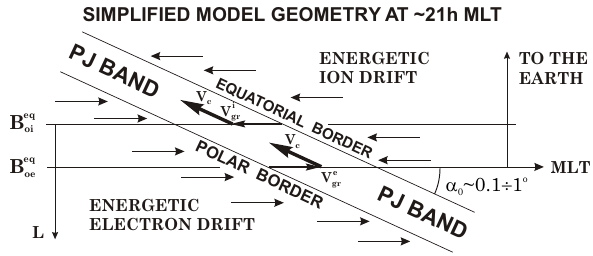
Table 1. “Resonance” ion energies er for different PJ convection